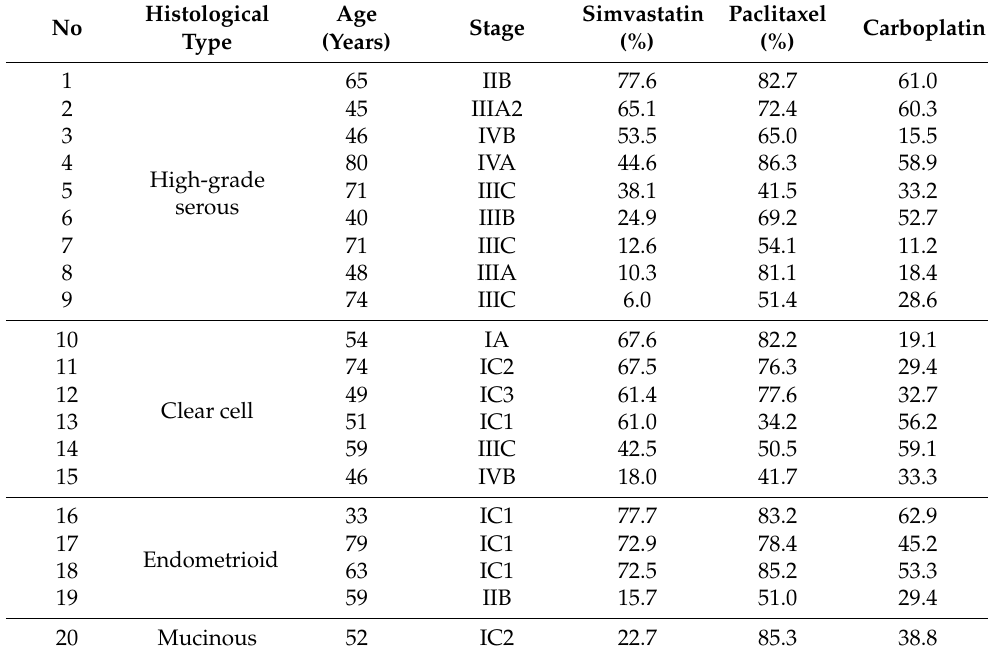
Table 2. Clinical characteristics and inhibition index based on a histoculture drug response assay. Histological Age Simvastatin No Stage Type (Years)